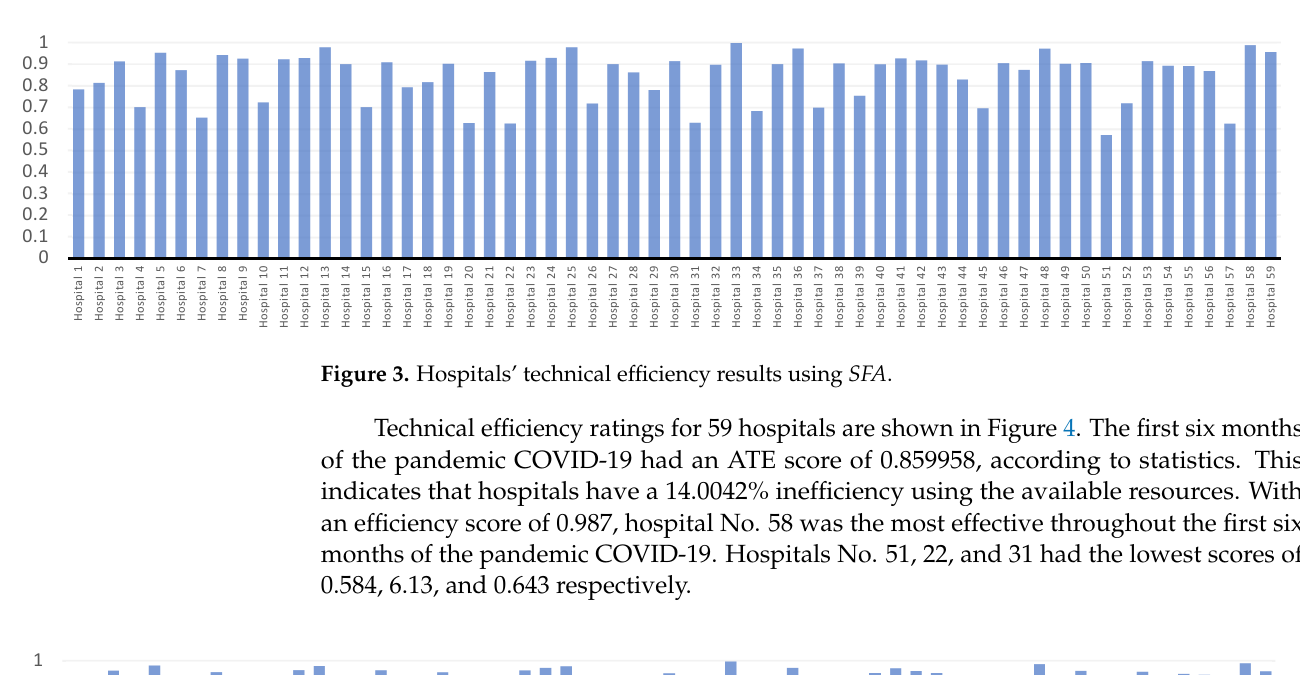
51, 57, and 22 have had the lowest efficiency scores of 0.571, 0.623, and 0.624, respectively.